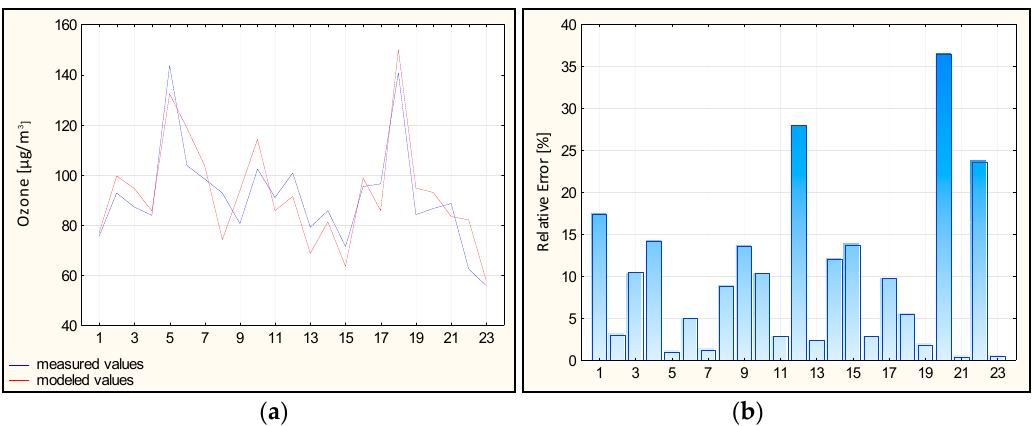
Figure 3. Results of modeling the daily maximum surface ozone concentration for validation subset (Warsaw station). ( a ) Measured vs. modeled surface ozone concentration values. ( b ) Relative error of forecasted ozone values. For both graphs: x -axis represents days from April to September 2015 that were randomly selected for the validation subset.